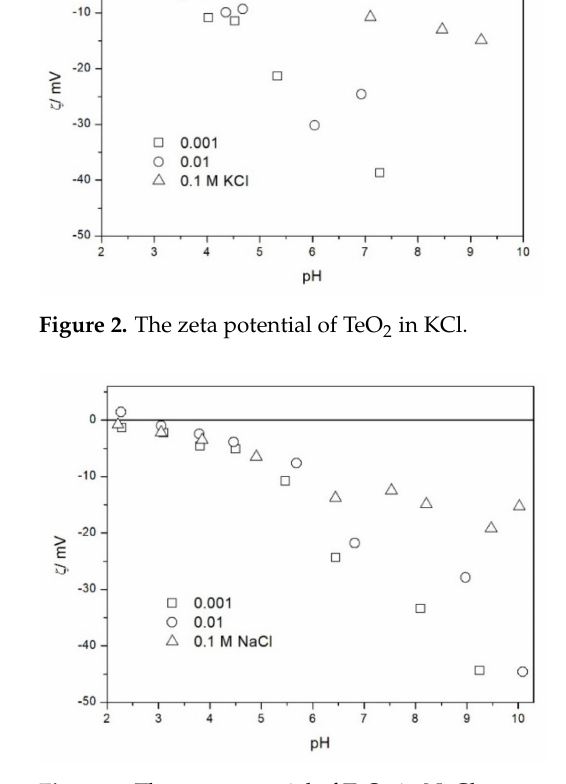
Figure 3. The zeta potential of TeO 2 in